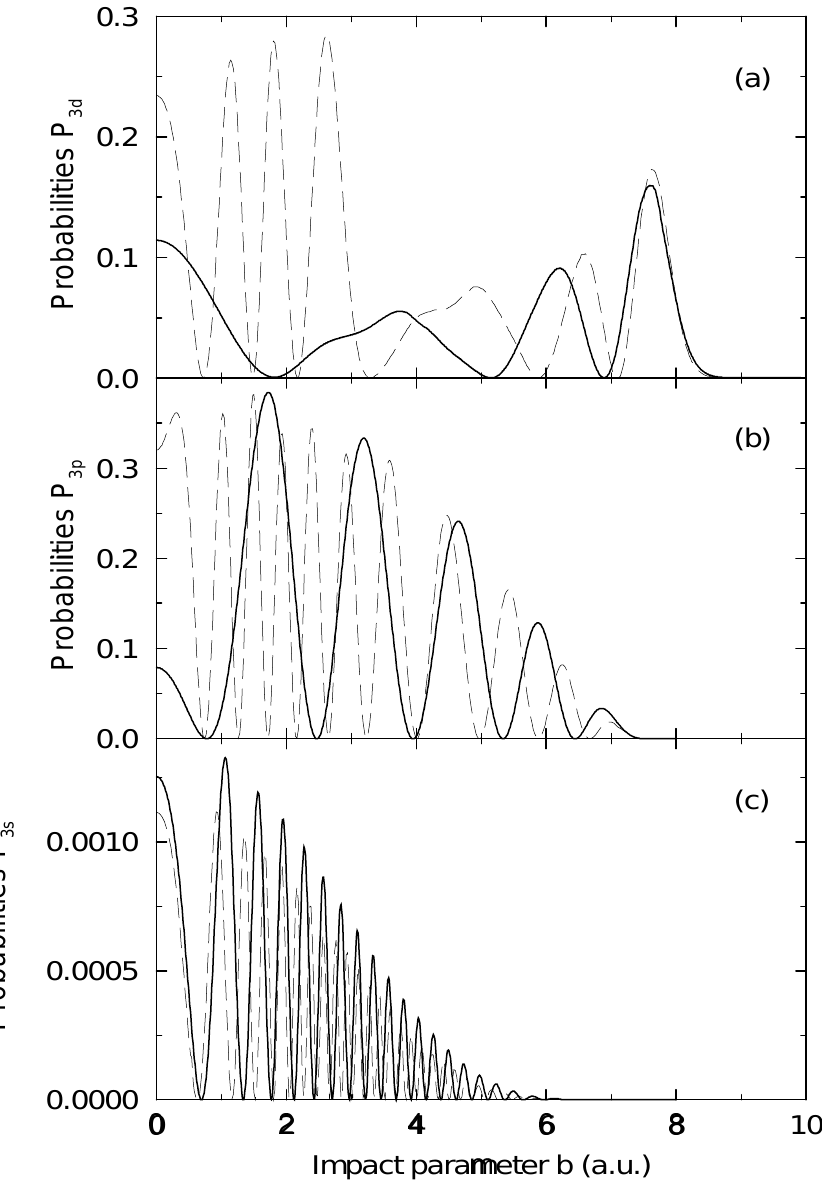
Figure 5: The transition probabilities for excitation of the C 3+ (3 d ) (a), C 3+ (3 p ) (b), and C 3+ (3 s ) (c) states in H + C 4+ (solid lines) and D + C 4+ (dashed lines) collisions for the collisional energy E = 10 eV/amu as the functions of the impact